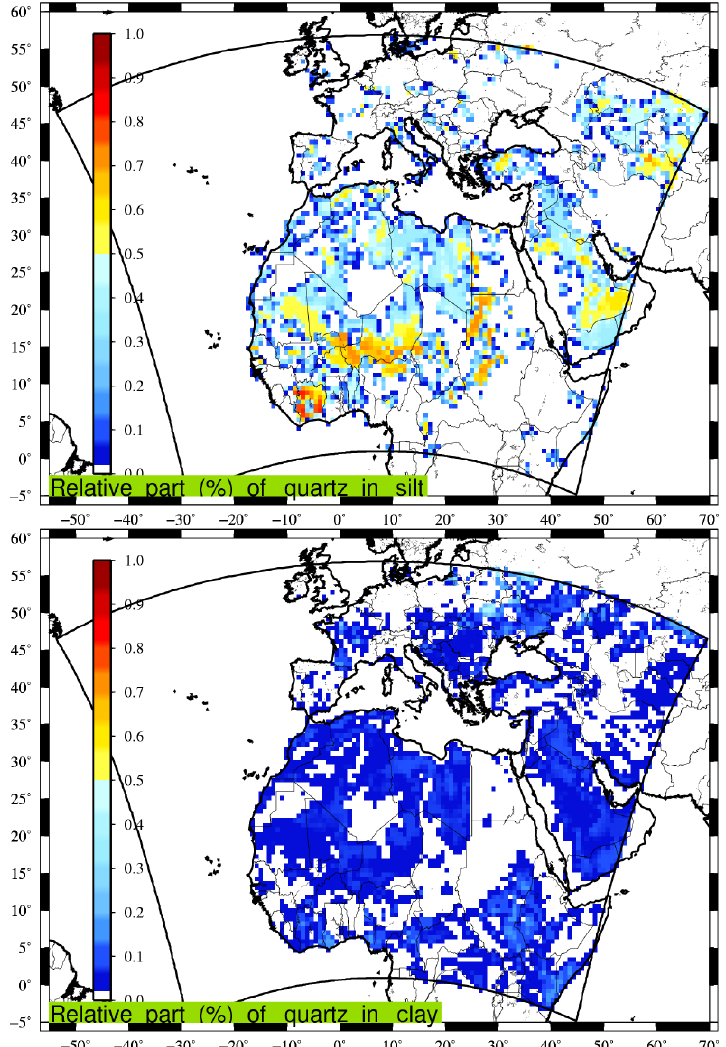
Figure 1. Example of the relative part (0 : 1) of the quartz mineral in the silt and clay fraction of the